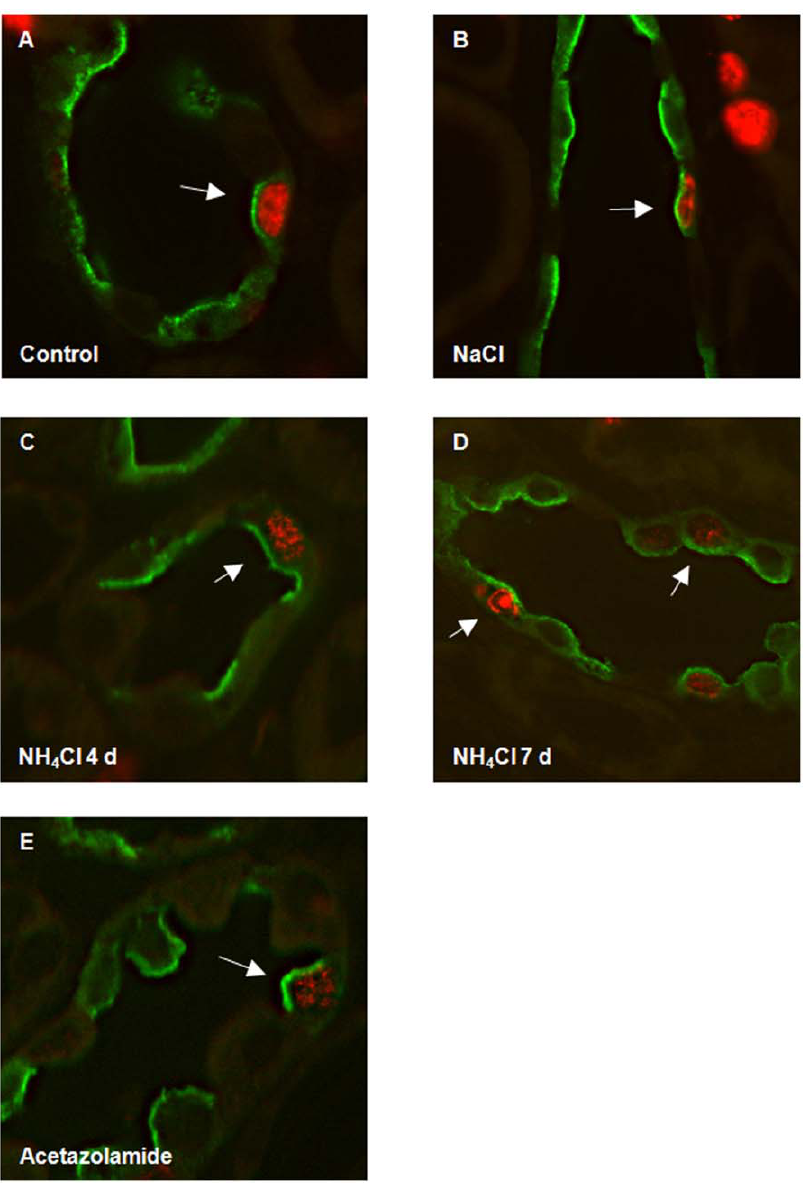
Figure 9. Proliferation of segment-specific cells in the outer medullary collecting duct (OMCD). Kidney sections were stained with antibodies against the AQP2 water channel (green), a marker of segment-specific cells, and against BrdU (red). Colocalization of both stainings was observed in cells of animal groups in the OMCD (arrows). doi:10.1371/journal.pone.0025240.g009 acetazolamide induced BrdU labelling of about 50% of all type A table 4). Acetazolamide and NaCl application was without detectable effect on BrdU incorporation.